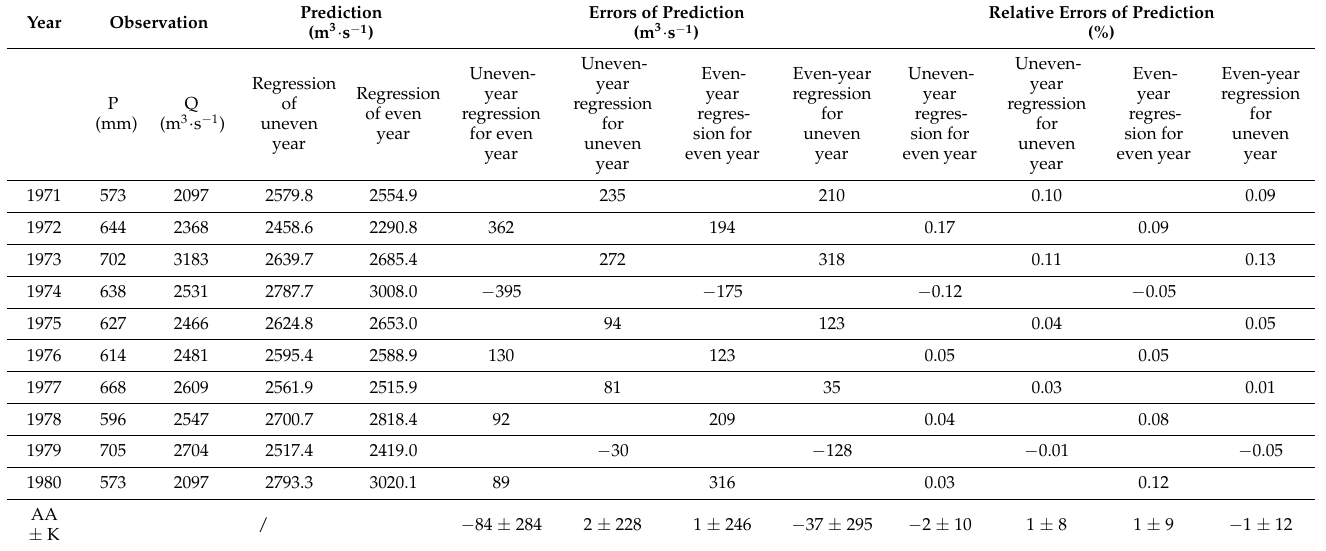
Table 7. Error estimation for predicted streamflow at Zhutuo station using the measured precipitation and annual runoff regression